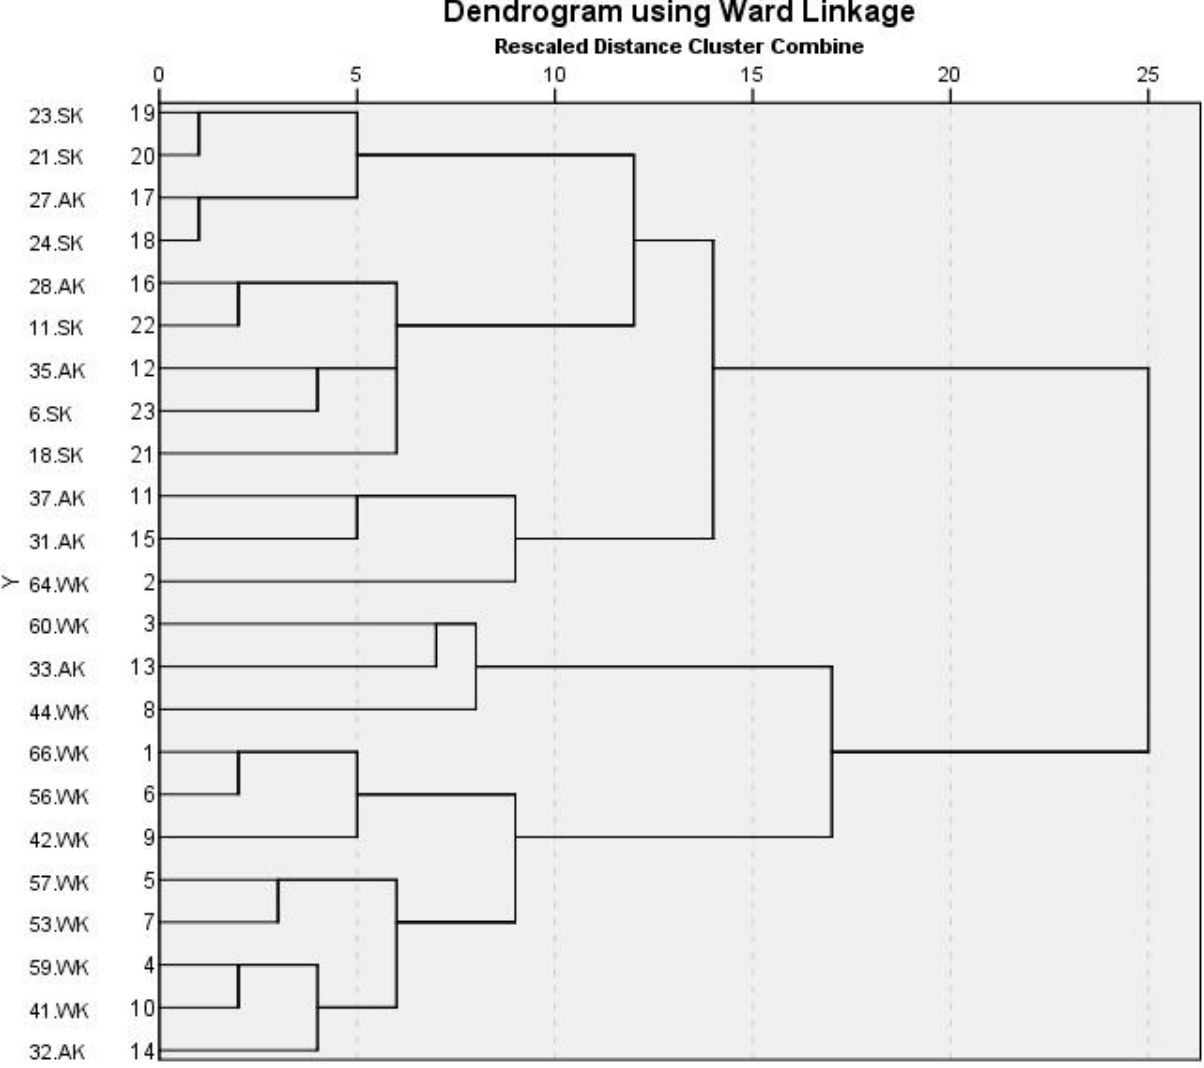
Figure 4. Dendrogram generated from ERIC-PCR genomic DNA products of 23 carbapenem-resistant Klebsiella spp. isolates harboring plasmids.